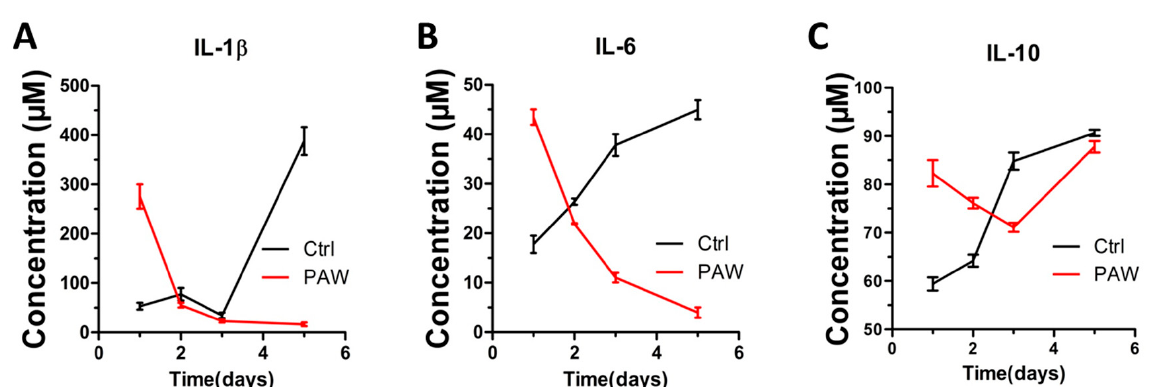
Figure 4. Skin inflammatory factor levels. ( A , B ) Comparison of pro-inflammatory cytokine expression in the wounded skin of mice in the control and PAW treatment groups at different time points (days 1, 2, 3, and 5). ( C ) Comparison of anti-inflammatory cytokine expression in wounded skin of mice in the control and PAW treatment groups at different time points (days 1, 2, 3, and 5).